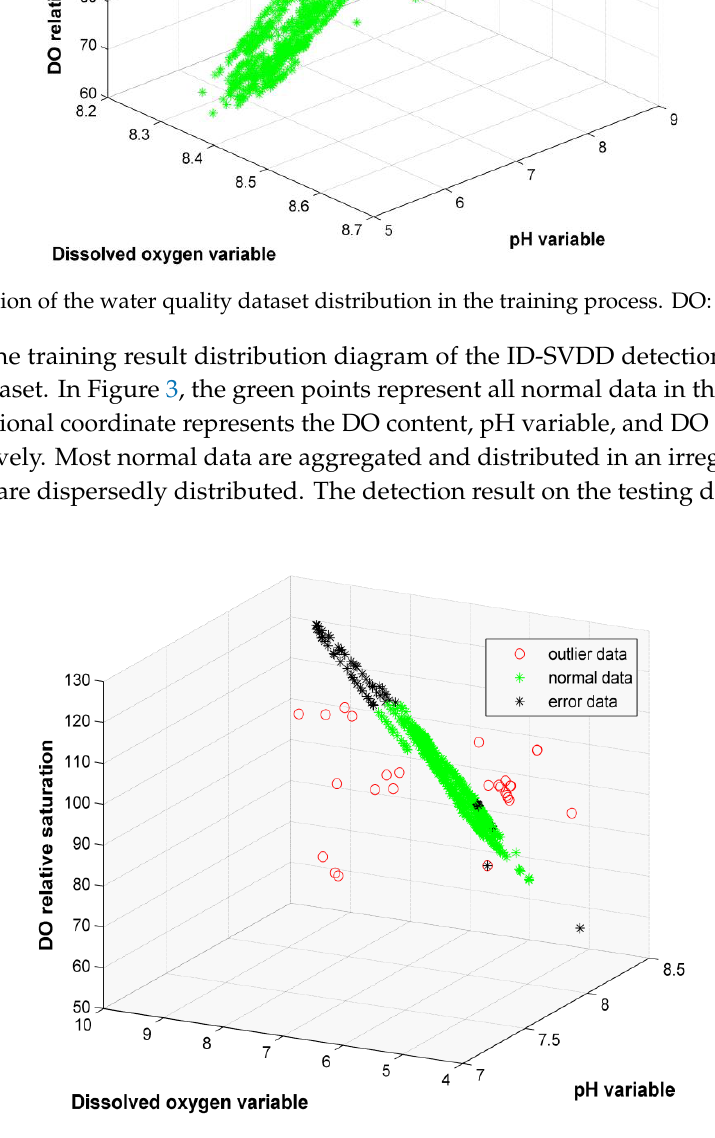
Figure 4. Detection results of the water quality dataset in the testing process.